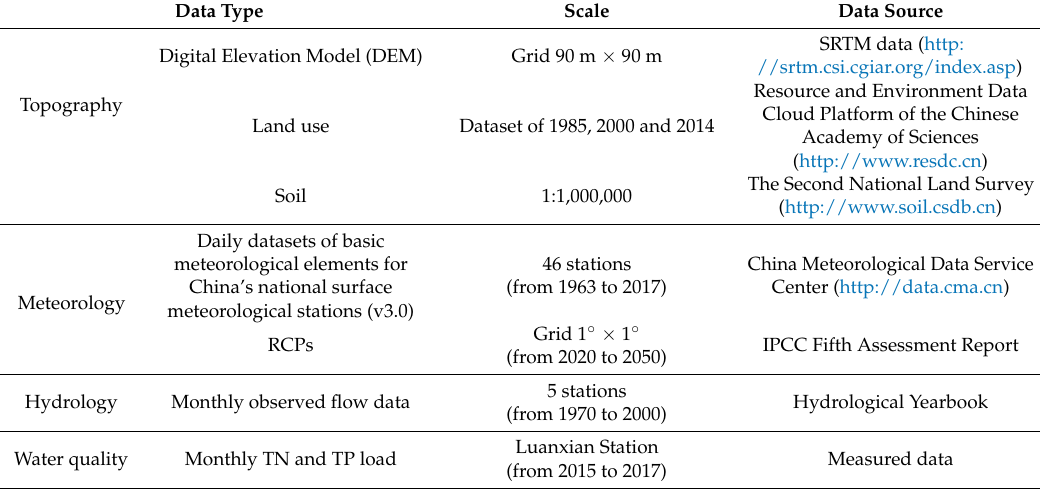
Table 1. The database and main sources.